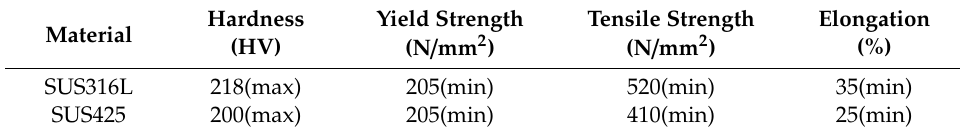
Table 2. Mechanical properties of base metals.